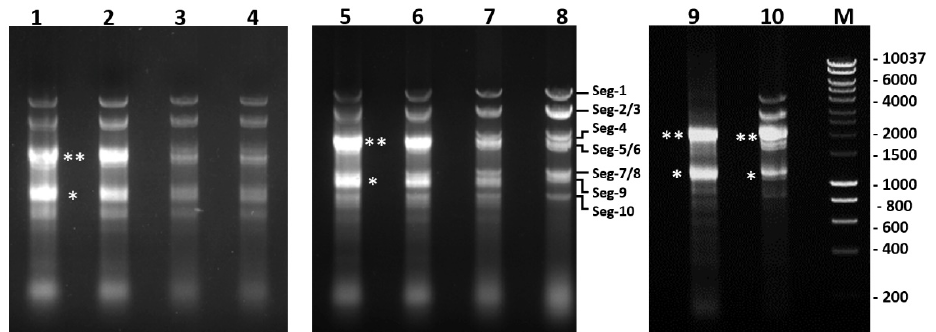
Figure 14. Analysis of total RNA extracted from BSR cells infected with BTV-1RG C7 , BTV-1 ∆ NS4 or BTV-1 ∆ NS5 at 34 h post-infection. Total RNA from BSR cells infected with BTV-1RG C7 (lanes 1, 5 and 10), BTV-1 ∆ NS4 (lanes 2 and 6), BTV-1 ∆ NS5 (lane 3), or BTV-1 ∆ NS5/ ∆ NS4 (lane 4) analysed by agarose gel electrophoresis. Lanes 1 and 2 contained similar amounts of viral dsRNA, which were higher than those visible in lanes 3 and 4. Lane 7: total RNA extract of BTV-1 ∆ NS5 infected cells ( fi ve times the quantity shown in lane 3). Lane 8: dsRNA of BTV-1RG C7 , in which 28S (**) and 18S (*) rRNA bands had been removed by LiCl puri fi cation. Lanes 9 and 10: total RNA extracts of non-infected or BTV-1RG C7 infected BSR cells, respectively. Lanes 3, 4, and 7 show li tt le rRNA as compared to lanes 1, 2, 5, 6, 9, and 10. Lane M: size marker labelled in bp. The 28S and 18S rRNA bands are indicated by ** and * respectively.